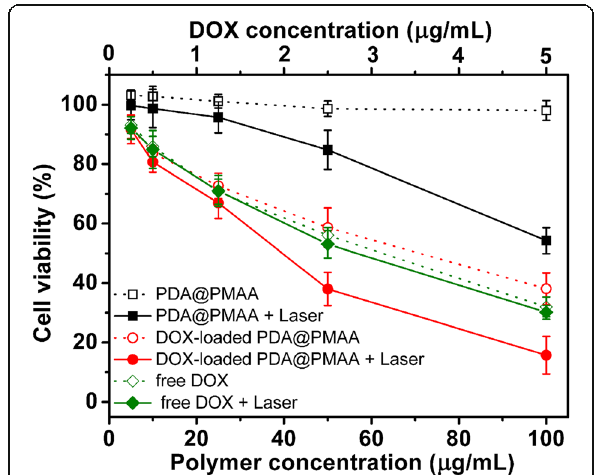
Fig. 9 Cell viability of A549 cells treated with free DOX, PDA@PMAA- 1 nanoparticles, and DOX-loaded PDA@PMAA-1 nanoparticles at various concentration without or with NIR laser irradiation ( λ = 808 nm, 5 W cm − 2 ) for 300 s